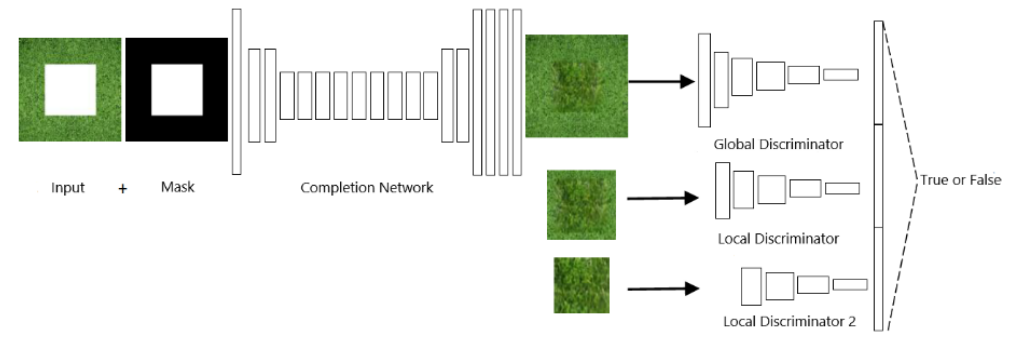
Figure 3. Overview of the network architecture we used.